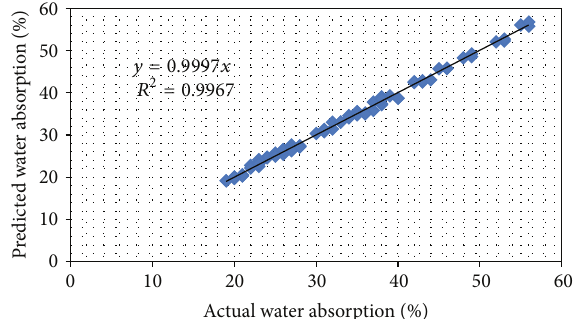
Figure 9: Performance of the water absorption by nonlinear regression model.